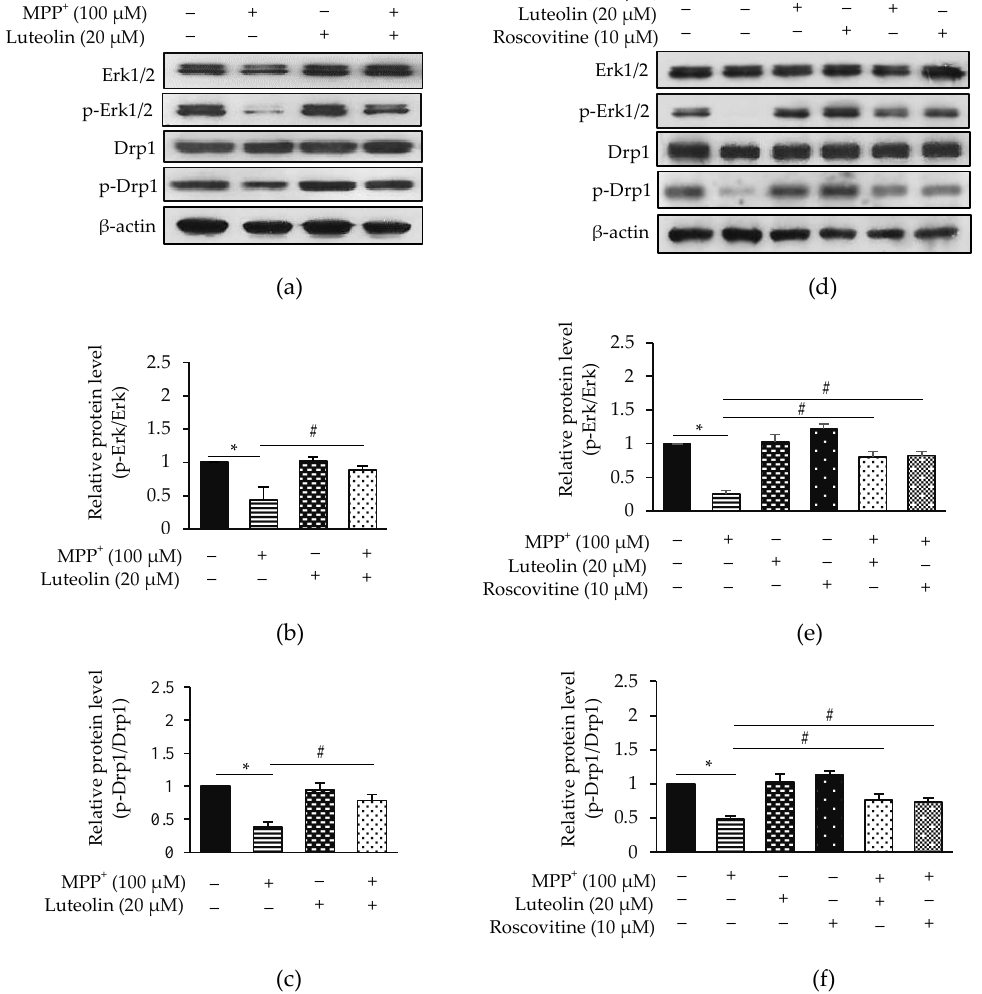
Figure 7. Luteolin protected MPP + -suppressed Erk1/2 and Drp1 in SH-SY5Y cells. Cells were pre-treated with 20 µM luteolin for 1 h, followed by treatment with 100 µM MPP + for 24 h. (a) Expressions of Erk, p-Erk, Drp1 and p-Drp1 were analyzed by western blot analysis. Quantification of (b) p-Erk/Erk and ( c ) p-Drp1/Drp1 was shown in the bar graph. Cells were pre-treated with 20 µM luteolin and 10 µM roscovitine for 1 h, followed by treatment with 100 µM MPP + for 24 h. ( d ) Expressions of Erk, p-Erk, Drp1 and p-Drp1 were analyzed by western blotting. Quantification of ( e ) p-Erk/Erk and ( f ) p-Drp1/Drp1 was shown in the bar graph. Data were normalized using β -actin as control. Results presented as the mean ± SD for triplicated independent experiments. Differences are statistically significant at * p < 0.05 versus the control group, and # p < 0.05 versus the MPP + group.